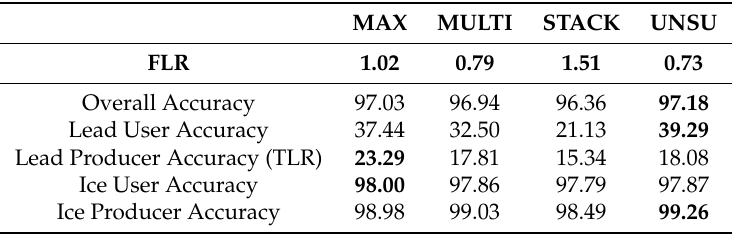
Table 2. Accuracies for each classifier in (%). Values provided for FLR of about 1% ( w = 3, k = 25). The best performance for each of the accuracy metrics is marked in